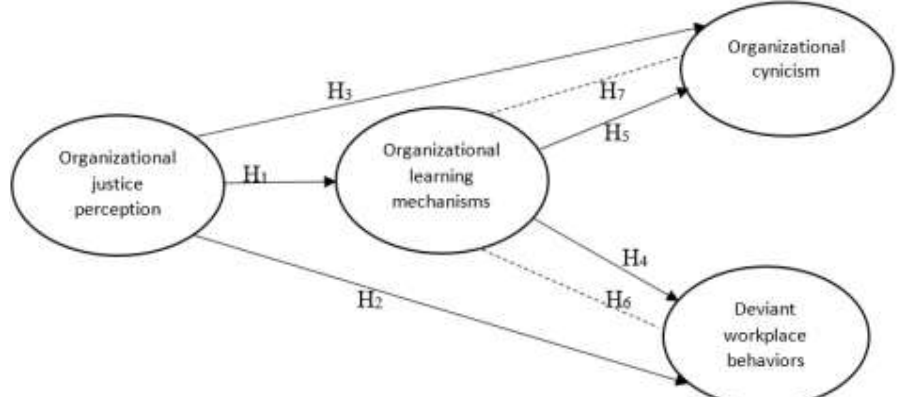
Figure 1. Theoretical model and hypotheses of the research